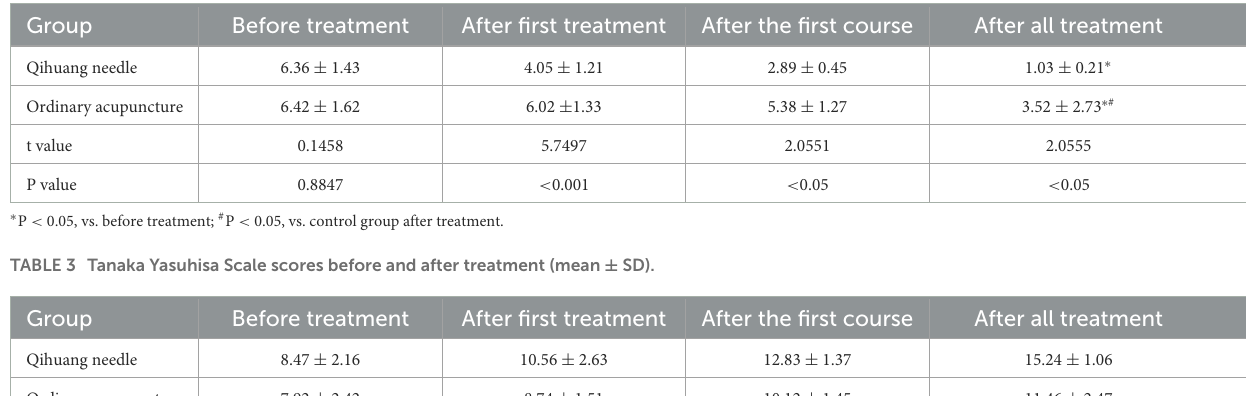
TABLE 2 Visual analog scale (VAS) score before and after treatment (mean ± SD). Group Before treatment After first treatment After the first course After all treatment